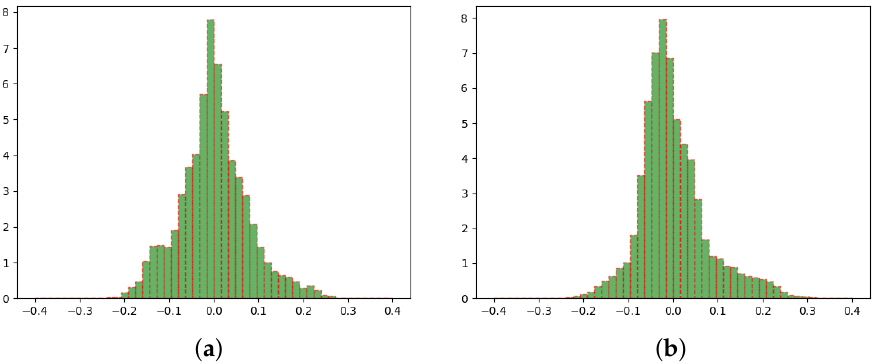
Figure 1. Histograms regarding the difference between hourly power demands, for residential and enterprise customers. ( a ) Residential customers. ( b ) Enterprise